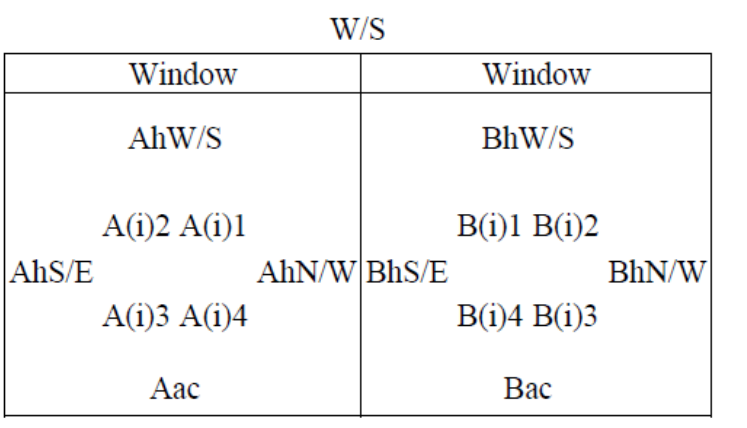
Figure 4. Symbol Description.